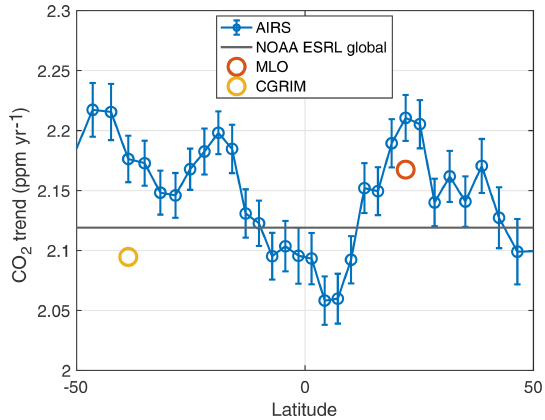
Figure 11. Observed linear trend in the AIRS CO 2 anomalies ver- sus latitude, compared to NOAA ESRL Mauna Loa (MLO), ESRL Cape Grim (GCRIM), and the ESRL global CO 2 product trends (black line). Table 2. Slope of the (AIRS – ESRL) CO 2 anomalies in ppmyr − 1 units. Data